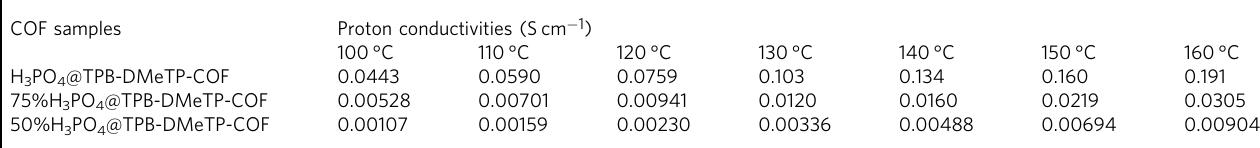
Table 2 Anhydrous proton conductivity of H 3 PO 4 @TPB-DMeTP-COF, 75%H 3 PO 4 @TPB-DMeTP-COF and 50%H 3 PO 4 @TPB- DMeTP-COF at different